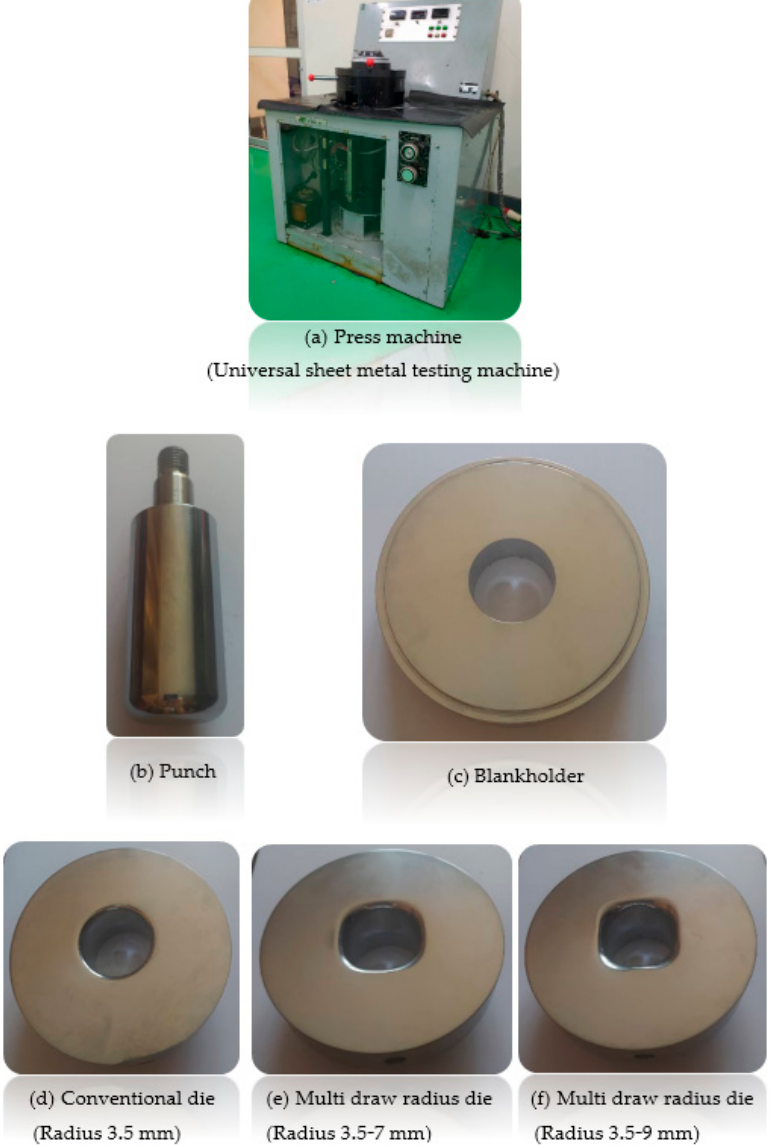
Figure 4. Press machine and set of punch and die: ( a ) Press machine (Universal sheet metal testing machine); ( b ) Punch; ( c ) Blankholder; ( d ) Conventional die (radius 3.5 mm); ( e ) Multi draw-radius die (radius 3.5–7mm); ( f ) Multi draw-radius die (radius 3.5–9mm).